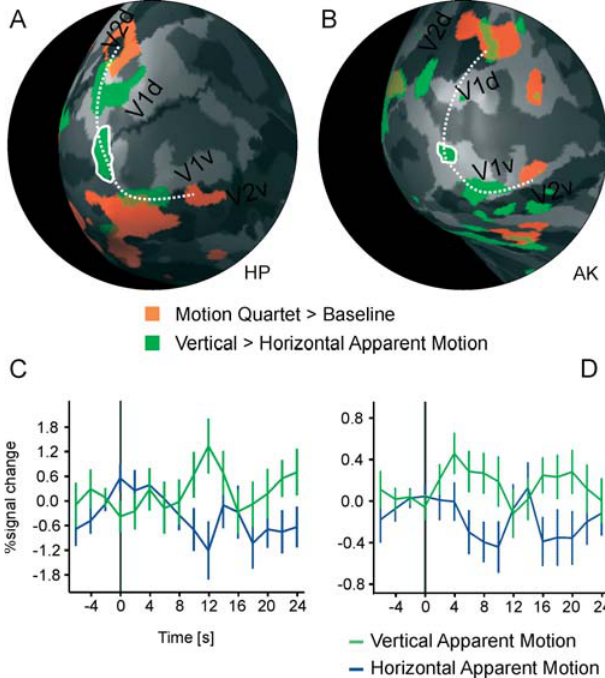
Figure 6. Results from the Bistable Motion Quartet (Experiment 3) (A and B) Medio-posterior view on the inflated left occipital cortex of subject HP (A) and AK (B) (all six subjects are shown in Figure S3). Gray shading indicates the extension of V1 (light gray for V1) and the cortex curvature (dark gray, concave; light gray, convex). Activation maps show the cortical representation of the stimulated locations in red (motion quartet . baseline). Contrast maps in green indicate regions that are more active for vertical apparent motion than for horizontal apparent motion (ROI-based GLM at indicated locations; HP: t [301] . 2.5, p , 0.02; AK: t [708] . 2, p , 0.05). The dotted line is a spline-interpolated curve connecting the stimulated locations and the region that is more active during the perception of vertical apparent motion. (This line does not necessarily indicate the path of apparent motion from experiments 1 and 2 since stimulus parameters had to be adjusted.) (C and D) The solid white lines mark regions from which event-related averages were calculated. Event-related averages are shown for subject HP (C) and for subject AK (D). The time courses are aligned to the time point at which the subject indicates a switch in perception ( t ¼ 0, black line) and are shown for the time period from 4 s before to 24 s after the perceptual switch. The first perceptual period following each stimulation onset is omitted from the analysis (see Materials and Methods). Error bars correspond to standard errors of the mean. For HP, the vertical percept lasted on average for 11.9 s (standard deviation, 10.3 s), the horizontal for 13.4 s (standard deviation, 9.2 s). For AK, the vertical lasted for 14.6 s (standard deviation, 7.1 s), and the horizontal for 16.6 s (standard deviation, 6.7 s). DOI: